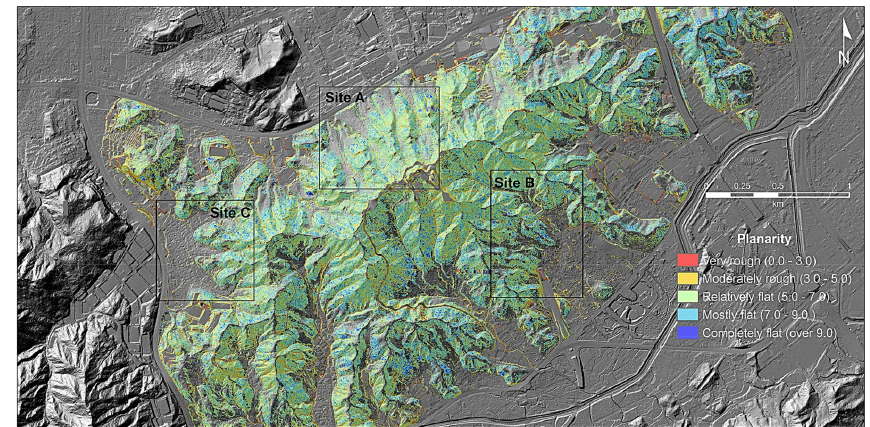
Figure 9. Spatial distribution of the modified planarity where the mean slope value is greater than 19 ◦ over the effective study area. Areas outlined by black rectangles are shown in Figs. 10 to